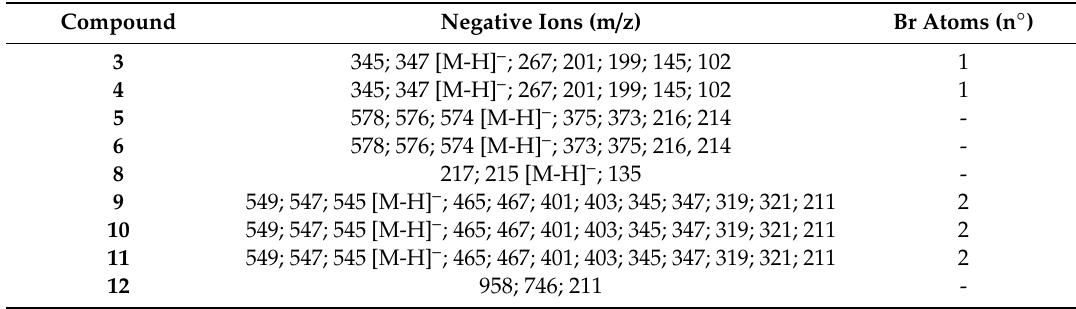
Table 2. Fragmentation pattern of the detected analytes in HIE / n extract applying a negative ionization mode and various fragmentors (80, 120 and 160 V).